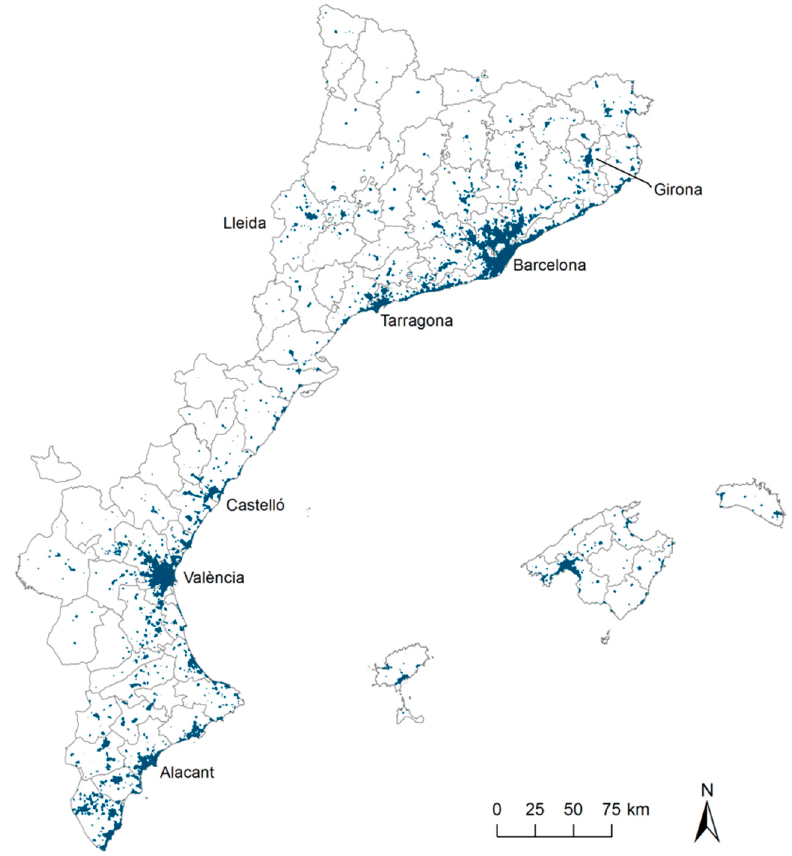
Figure 5 . Surface area of urban brightness (>10), mean for the months of October. Figure 5. Surface area of urban brightness (>10), mean for the months of